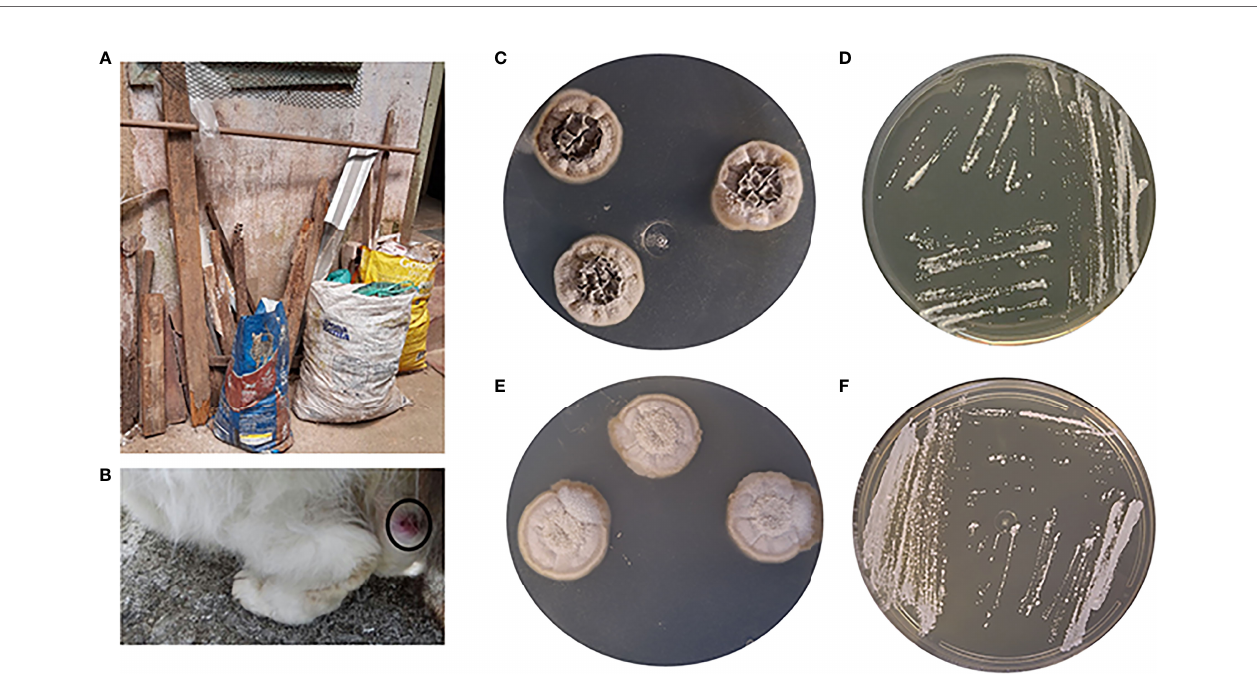
FIGURE 1 | (A) Wood disposal in the garden of the studied house. (B) Cat with sporotrichosis. (C, D) S . brasiliensis isolated from wood. (E, F) S . brasiliensis isolated from cat. (C, E) Filamentous form (13 days at 25°C). (D, F) Yeast form (7 days at